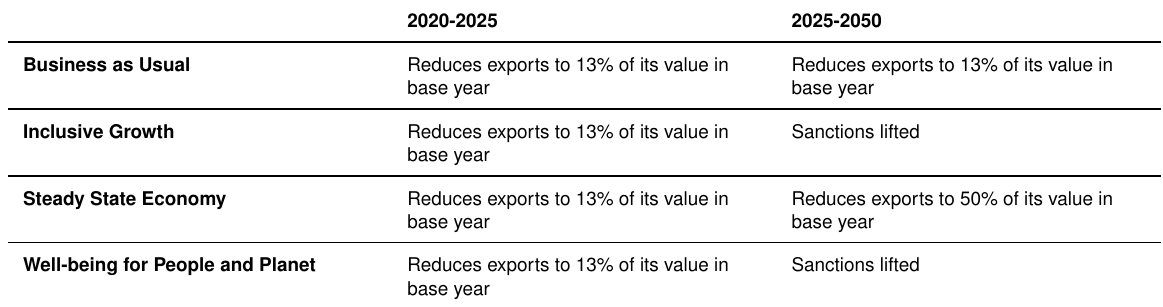
Table 7. The effect of sanctions on exports in different